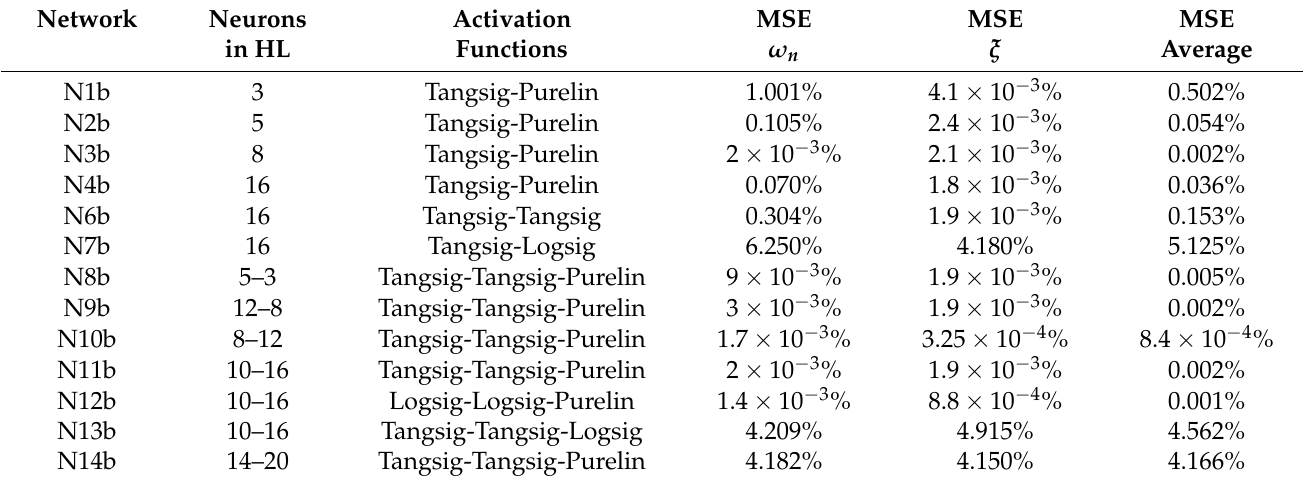
Table 4. Relevant tests for determining the architecture of ANN in underdamped systems.